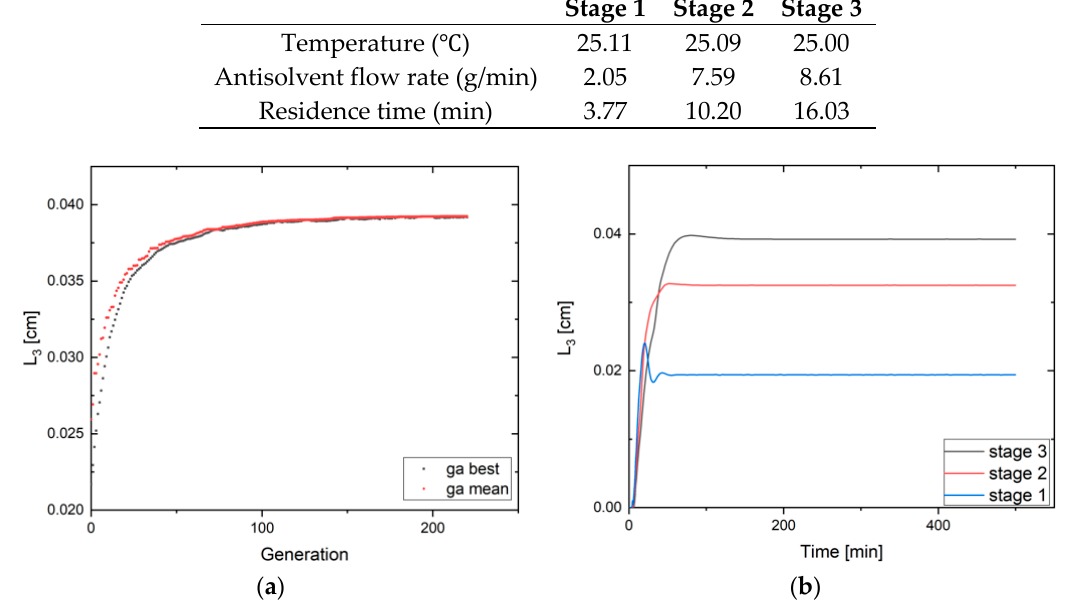
Table 3. Optimal temperatures, antisolvent flowrates, and residence times obtained in the case of the maximization of the average crystal size.